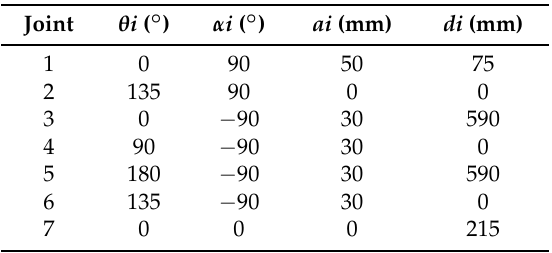
Table 3. Initial values of the arm D-H model geometric